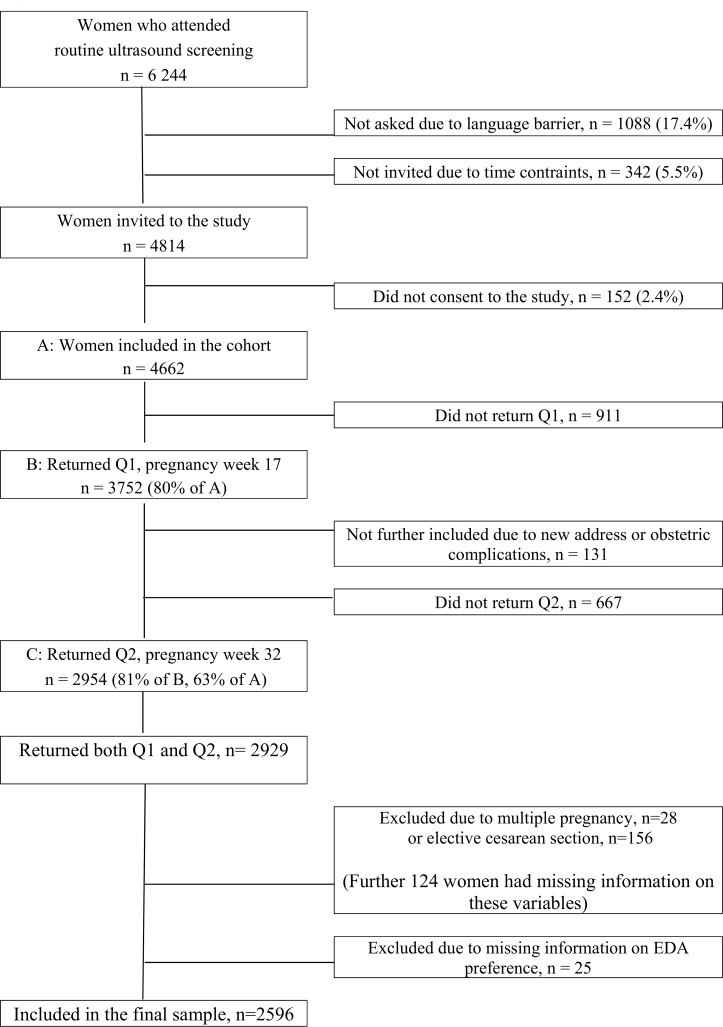
Flow chart displaying the recruitment and retention of the participants used in the present study.